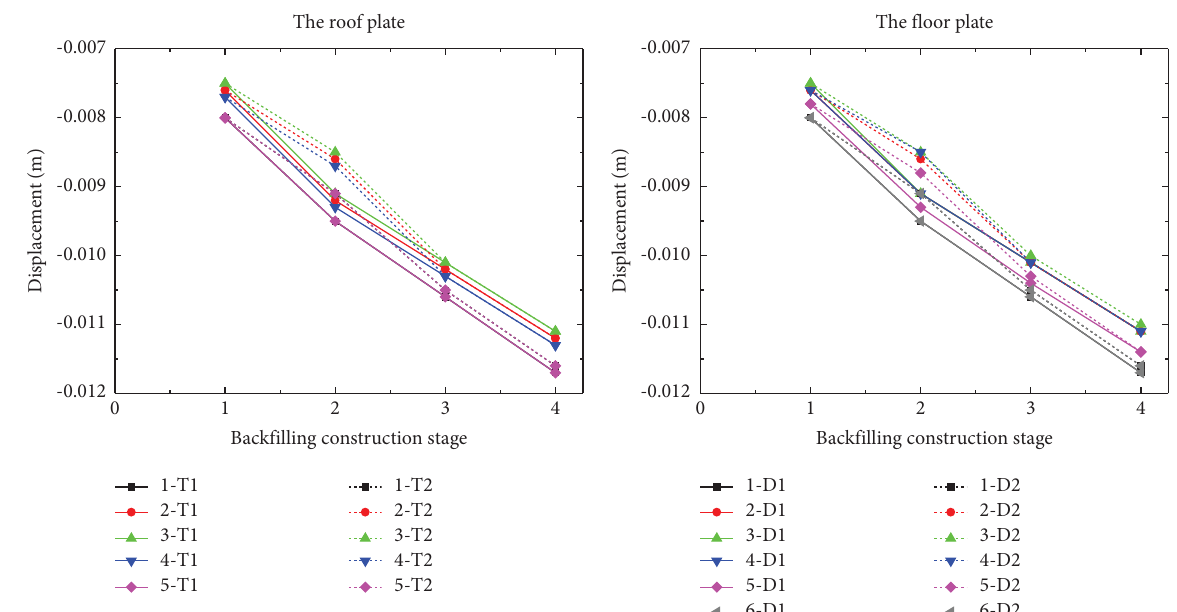
Figure 20: ( Y )-direction virtual displacement of the roof/foor in the middle-to-side backflling mode.